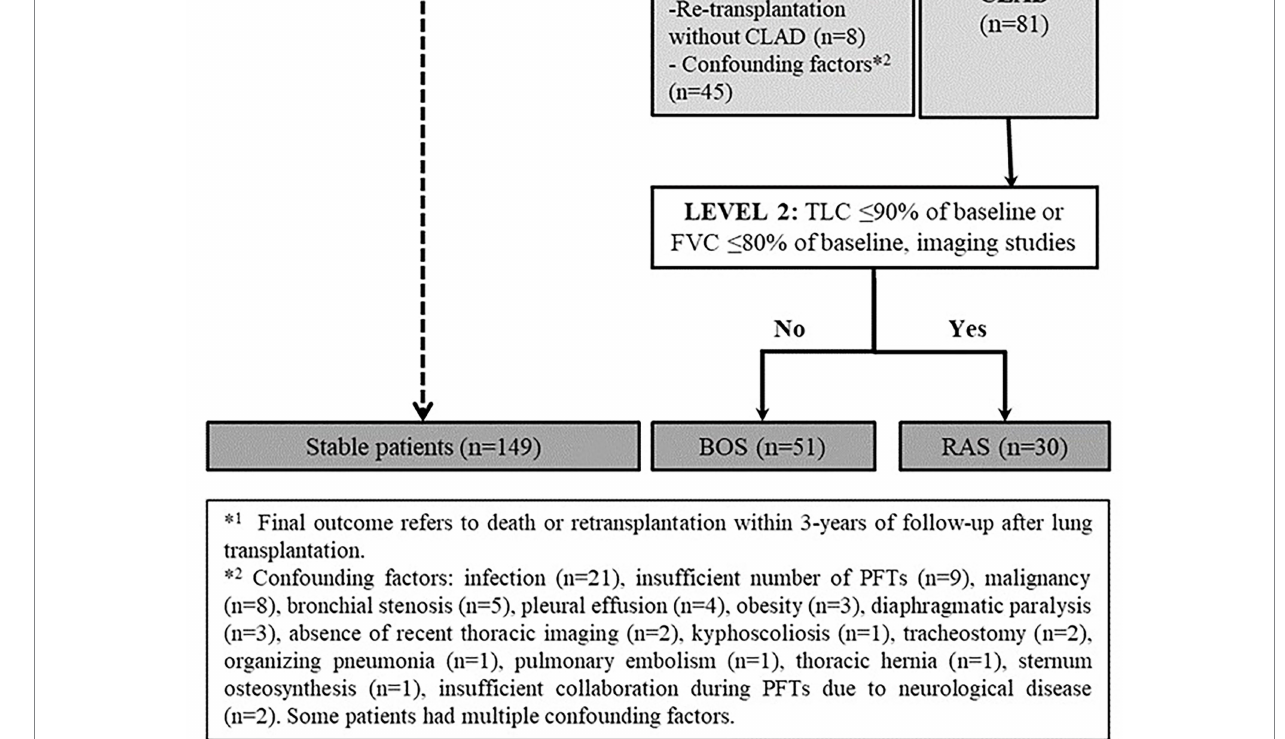
FIGURE 1 Flow chart diagram of the evaluated population, adapted from